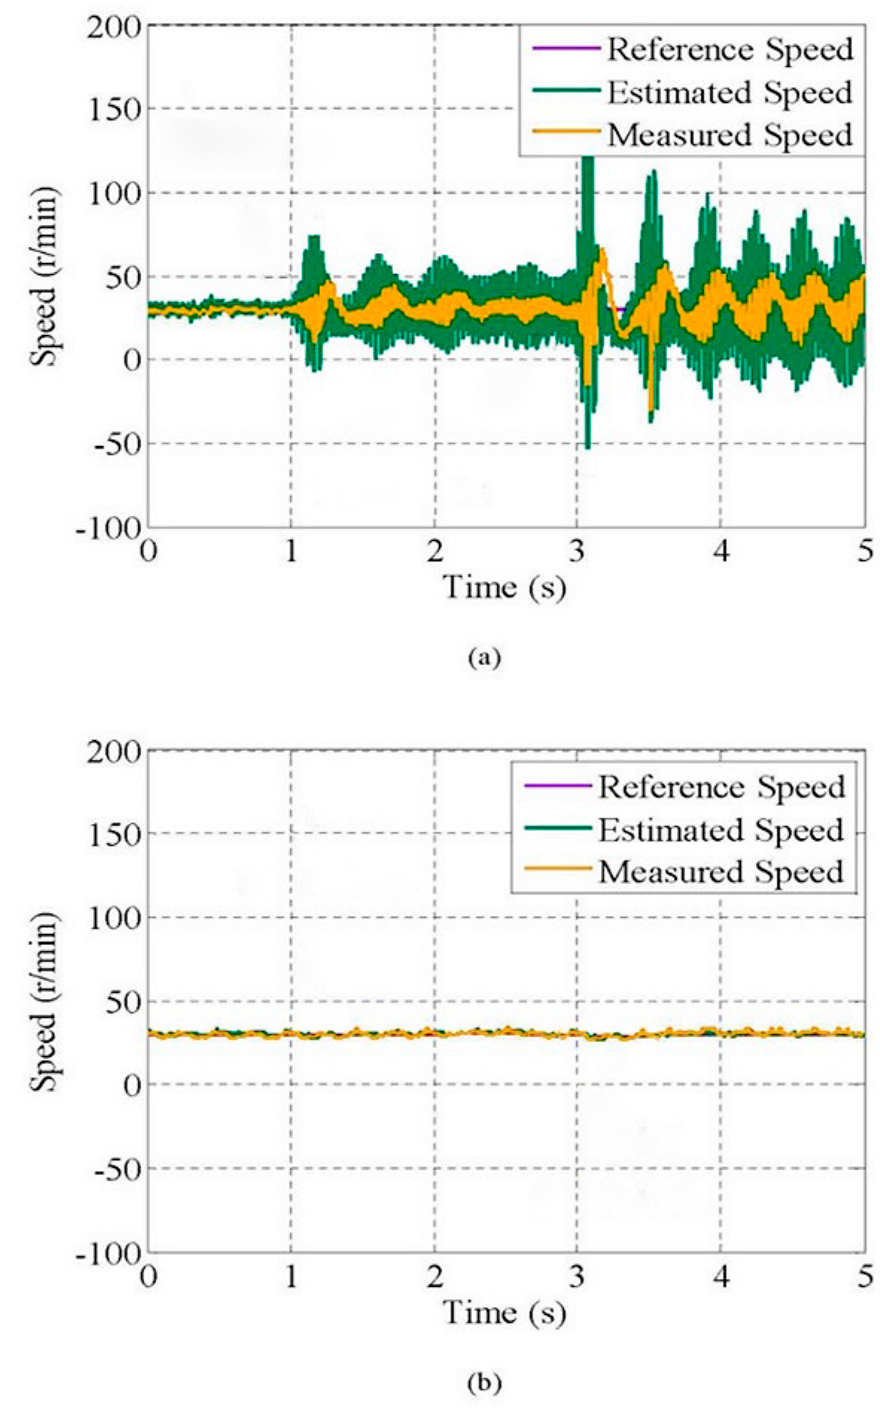
Figure 13. Speed-tracking performance under the L m change at no load. ( a ) model reference adaptive system (MRAS) control method. ( b ) Proposed model predictive control (MPC)-MRAS control method.